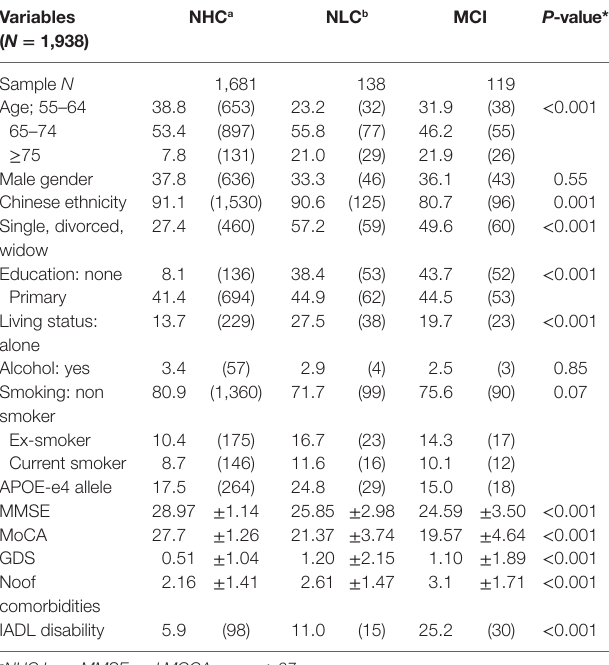
Table 1 | Demographic and personal characteristics among mild cognitive impairment (MCI), normal high cognition (NHC), normal low cognition (NLC)